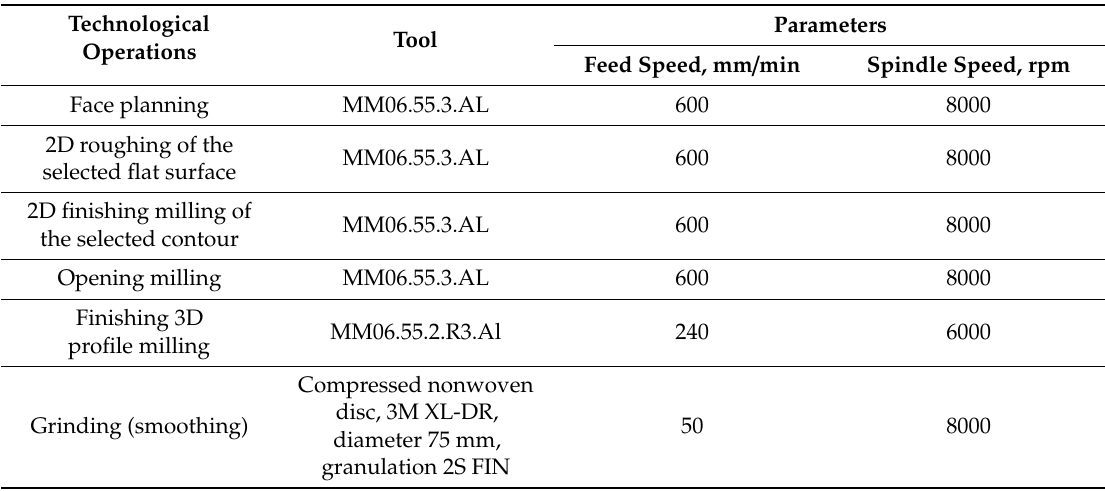
Table 3. List of technological operations for machining the test piece with assigned tools and machining